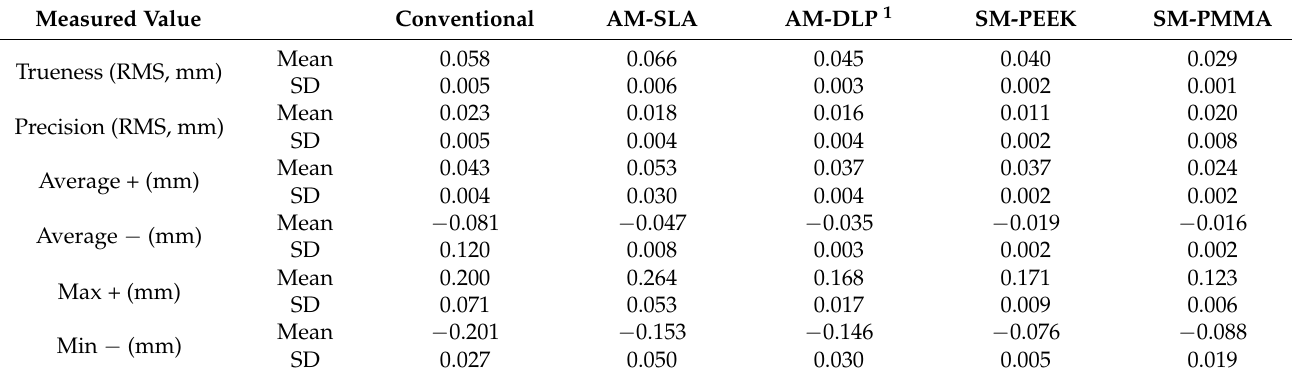
Table 1. Results from the superimposition process. Means and standard deviations are given for all groups for the following parameters: root mean square (RMS) of trueness, RMS of precision, positive and negative average deviation, as well as maximum and minimum deviations.